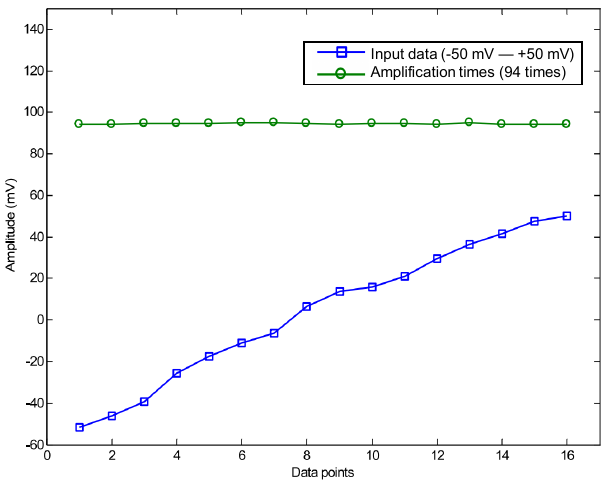
Figure 11. The relation of input signal amplitude and amplification ratio in DC testing.